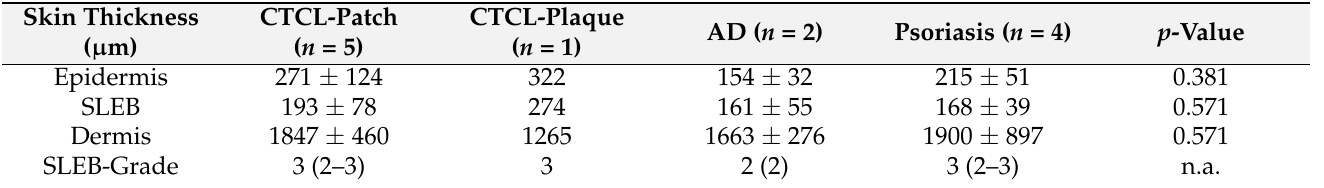
Figure 3. ( A – C ): Epidermal-, SLEB-, and Dermal thickness in CTLC, AD and Psoriasis. ( A ): Epidermal thickness in µm measured from the epidermal entrance echo to the upper border of the SLEB (average of 5 measurements per patient); ( B ): SLEB thickness in µm measured from the lower border of the epidermis to the upper dermal border (average of 5 meas- urements per patient); ( C ): dermal thickness in µm measured from the lower border of the epidermis or if present from the lower border of the SLEB to the interface of the dermis and hypodermis (average of 5 measurements per patient). Abbreviations: AD, atopic dermatitis; CTCL, cutaneous T-cell lymphoma; µm, micrometer; SLEB, subepidermal lower echogenic band.